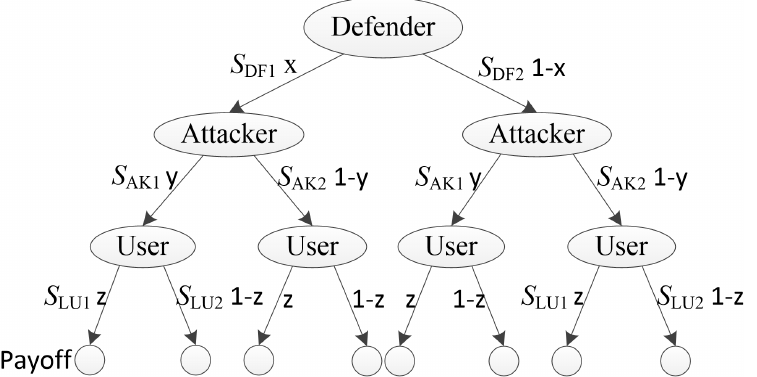
Figure 2. Three-party game relationship. Table 1. Payoff distribution of attacker, defender, and user.